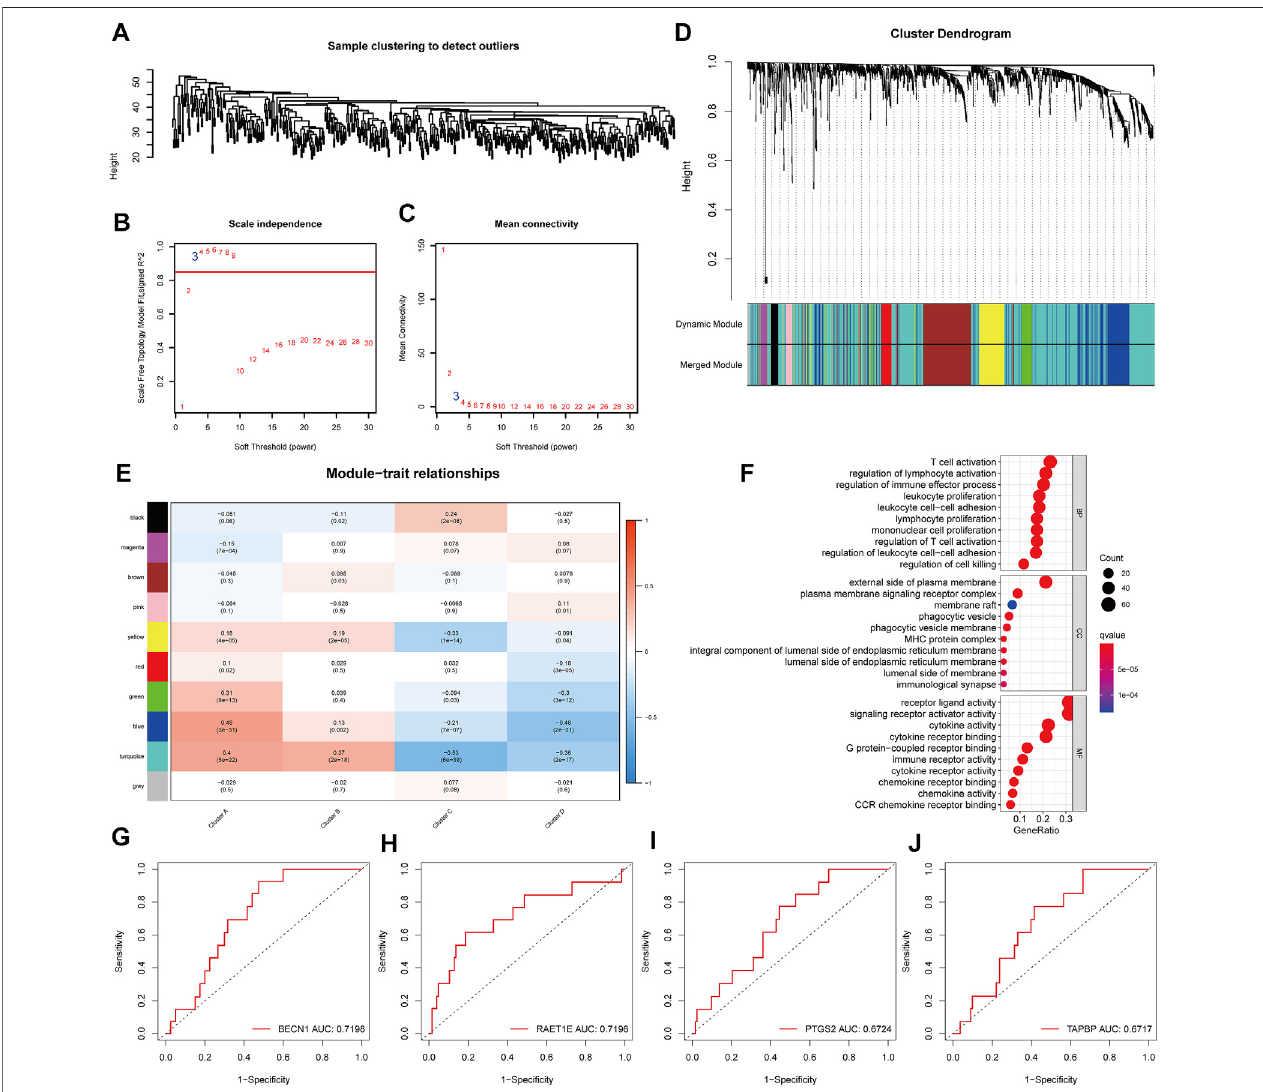
FIGURE 7 | Identi fi cation of gene co-expression network and identi fi cation of biomarkers in the suitable vaccinated population. (A – D) Identi fi cation of WGCNA genemodules. (E) Correlationanalysisbetweengenemodulesandimmuneclusters. (F) GeneOntology(GO)functionalenrichmentanalysisofgenesinthebluemodule. (G – J) Four potential prognostic biomarkers in cluster A patients eligible for mRNA vaccination.